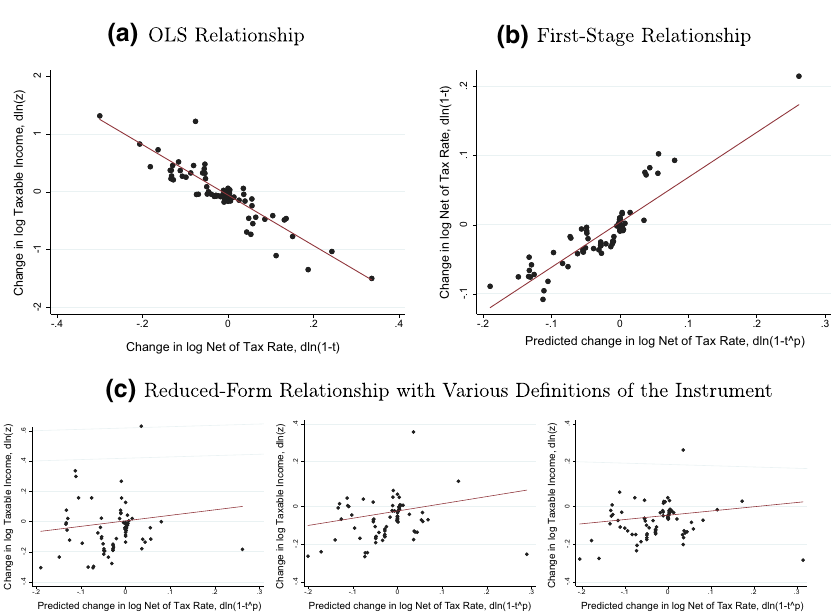
Fig. 2 Graphical analysis (1999–2014). Notes: Each dot in these figures represents the average of the vertical axis variable over bins of the horizontal axis variable, where the each bin contains a similar number of observations. a Represents the OLS relationship between the outcome variable of interest (cid:3) ln ( z ) and the endogenous covariate (cid:3) ln ( 1 − τ) . b Represents the first-stage relationship between the endogenous covariate (cid:3) ln ( 1 − τ) and the predicted tax rate instrument (cid:3) ln ( 1 − τ p ) . c Represents the reduced-form relationship between the outcome variable (cid:3) ln ( z ) and the instrument (cid:3) ln ( 1 − τ p ) , where the latter has been computed using one, two and three lags of taxable income. The regression lines depicted are estimated using the same number of observations as in the regressions in columns 1–3 of Table 3, without including any controls or fixed